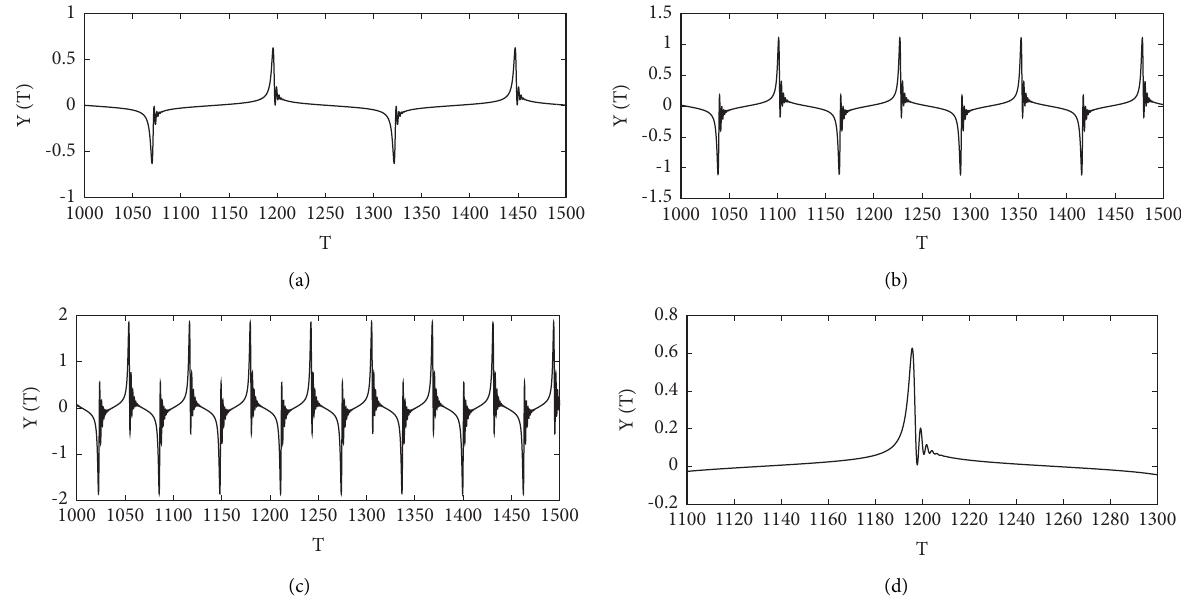
Figure 7: Quasiperiodic busting oscillations in the system for F � 27, ξ � 0 . 5, and α � 0 . 675: (a) ω � 0 . 025; (b) ω � 0 . 05; (c) ω � 0 . 1; (d) enlargement of